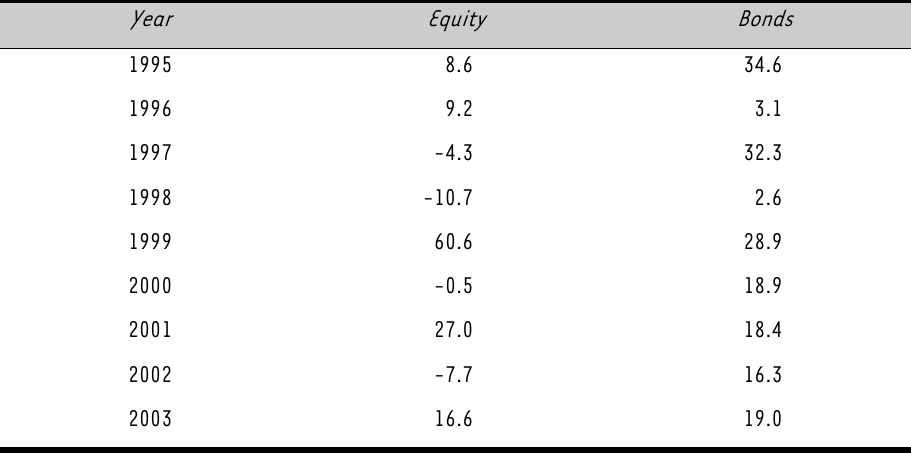
TABLE 2: Nominal returns, equity and bonds, 1995-2003